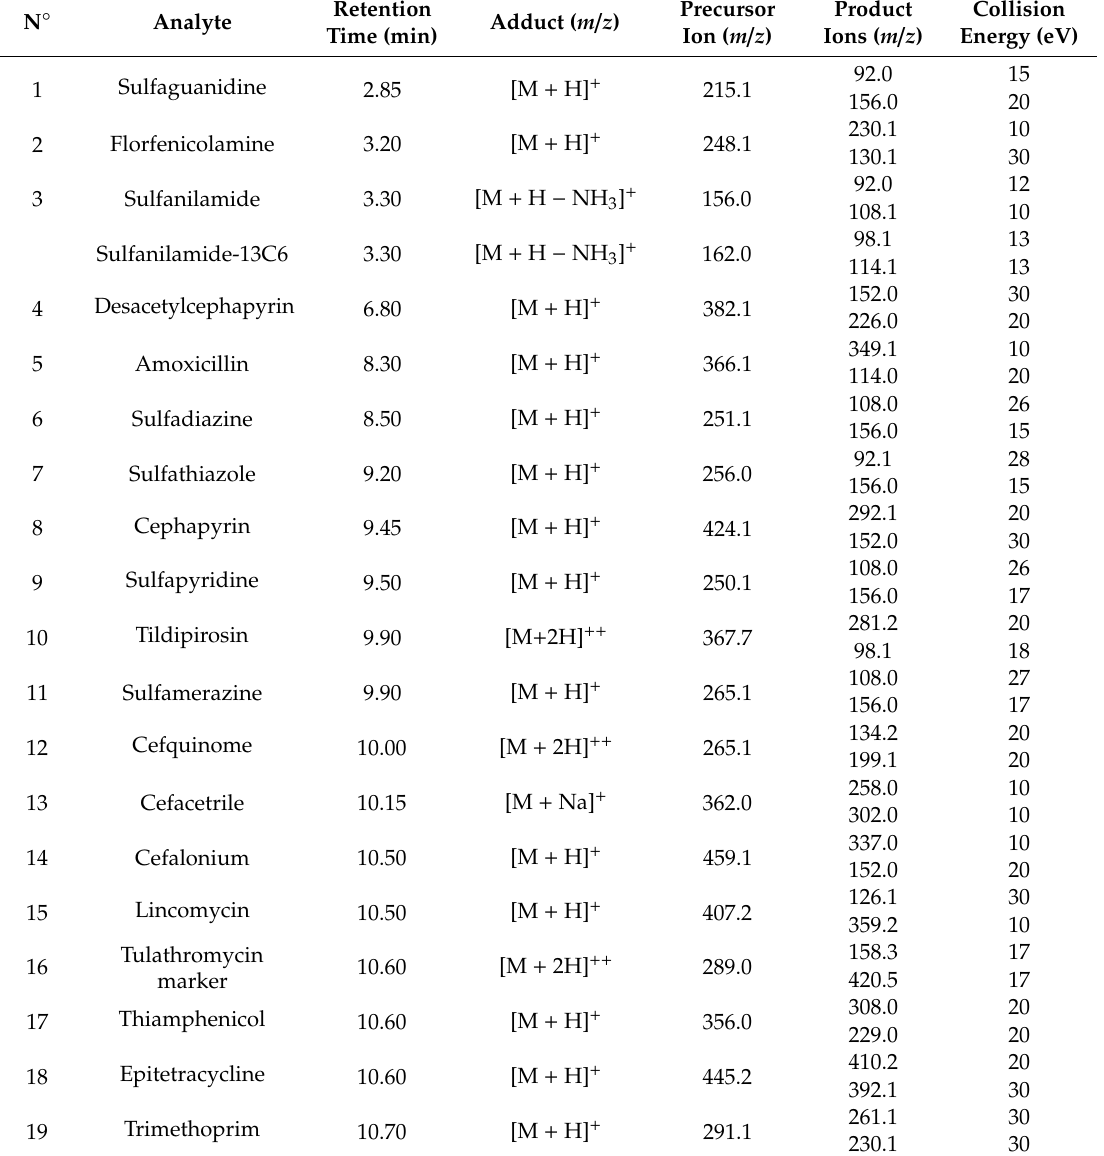
Table 2. Summary of the selected reactions transitions (SRM) monitored for the sixty-four targeted